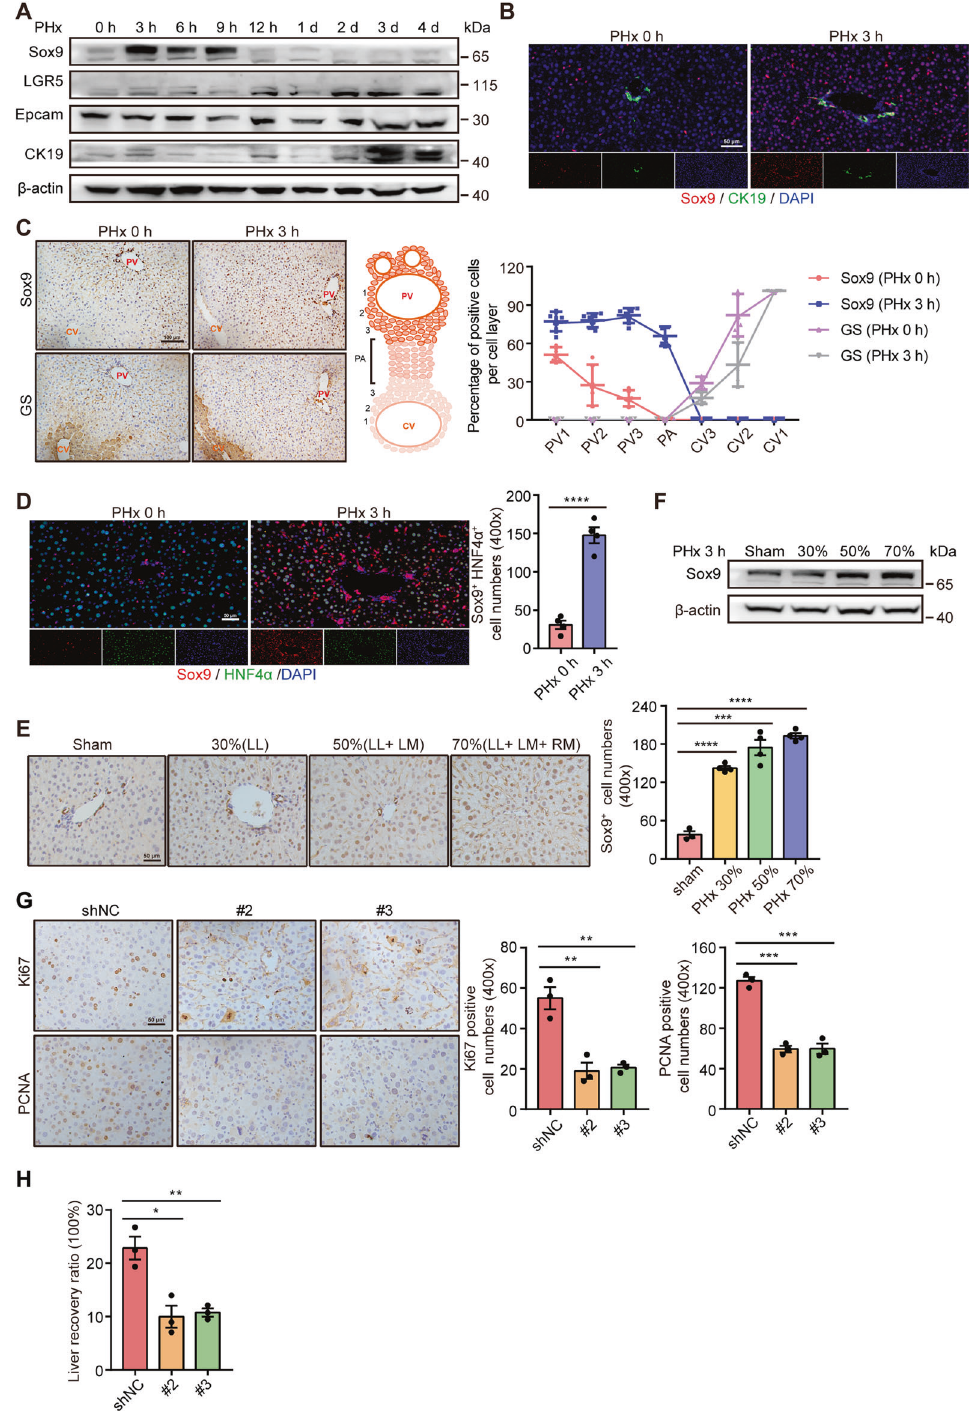
Fig. 1 Sox9 + HNF4 α + hepatocytes are involved in liver regeneration after PHx. A Representative western blotting analysis of liver stem cell markers at the indicated times after PHx. B Representative triple staining for Sox9 (red) and CK19 (blue) in the liver after PHx in wild-type mice. C Left: IHC analysis of liver at the indicated times after PHx to determine Sox9 and GS expression. GS functions as a maker for the central vein area. Right: Percentage of hepatocytes expressing GS and Sox9 in three cell layers around the central and portal veins and in the parenchyma (as indicated in the schematic). D Sox9 (red) and HNF4 α (green) double staining of liver sections at the indicated times after PHx. (Left panel, representative images; right panel, quantitative analysis of Sox9 + HNF4 α + cell numbers). E Left: IHC analysis of Sox9 in livers at 3 h after different proportions were removed by PHx. Right: Quanti fi cation of Sox9 + cell numbers. F The relative expression of Sox9 protein after different proportions of the liver were removed by hepatectomy. G Left: Relative expression of Ki67 and PCNA revealed by IHC staining in pDKD-Control and pDKD-Sox9 shRNA mice at the indicated times after PHx. Right: Quanti fi cation of Ki67- or PCNA-positive cells. H Liver recovery ratio in pDKD-Control and pDKD-Sox9 shRNA mice at day 3 after PHx. The data are expressed as the mean ± SEM. The measurement results were repeated at least 3 times and the results were similar. * p < 0.05, ** p < 0.01, *** p < 0.001, and **** p < 0.0001.